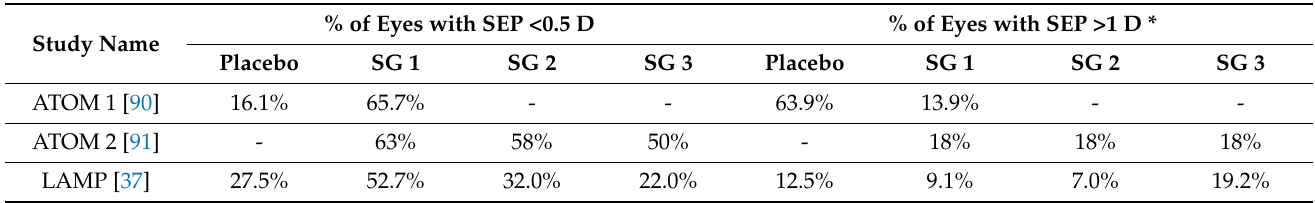
Table 2. Percentage of eyes with SEP <0.5 D and >1 D in the ATOM and LAMP